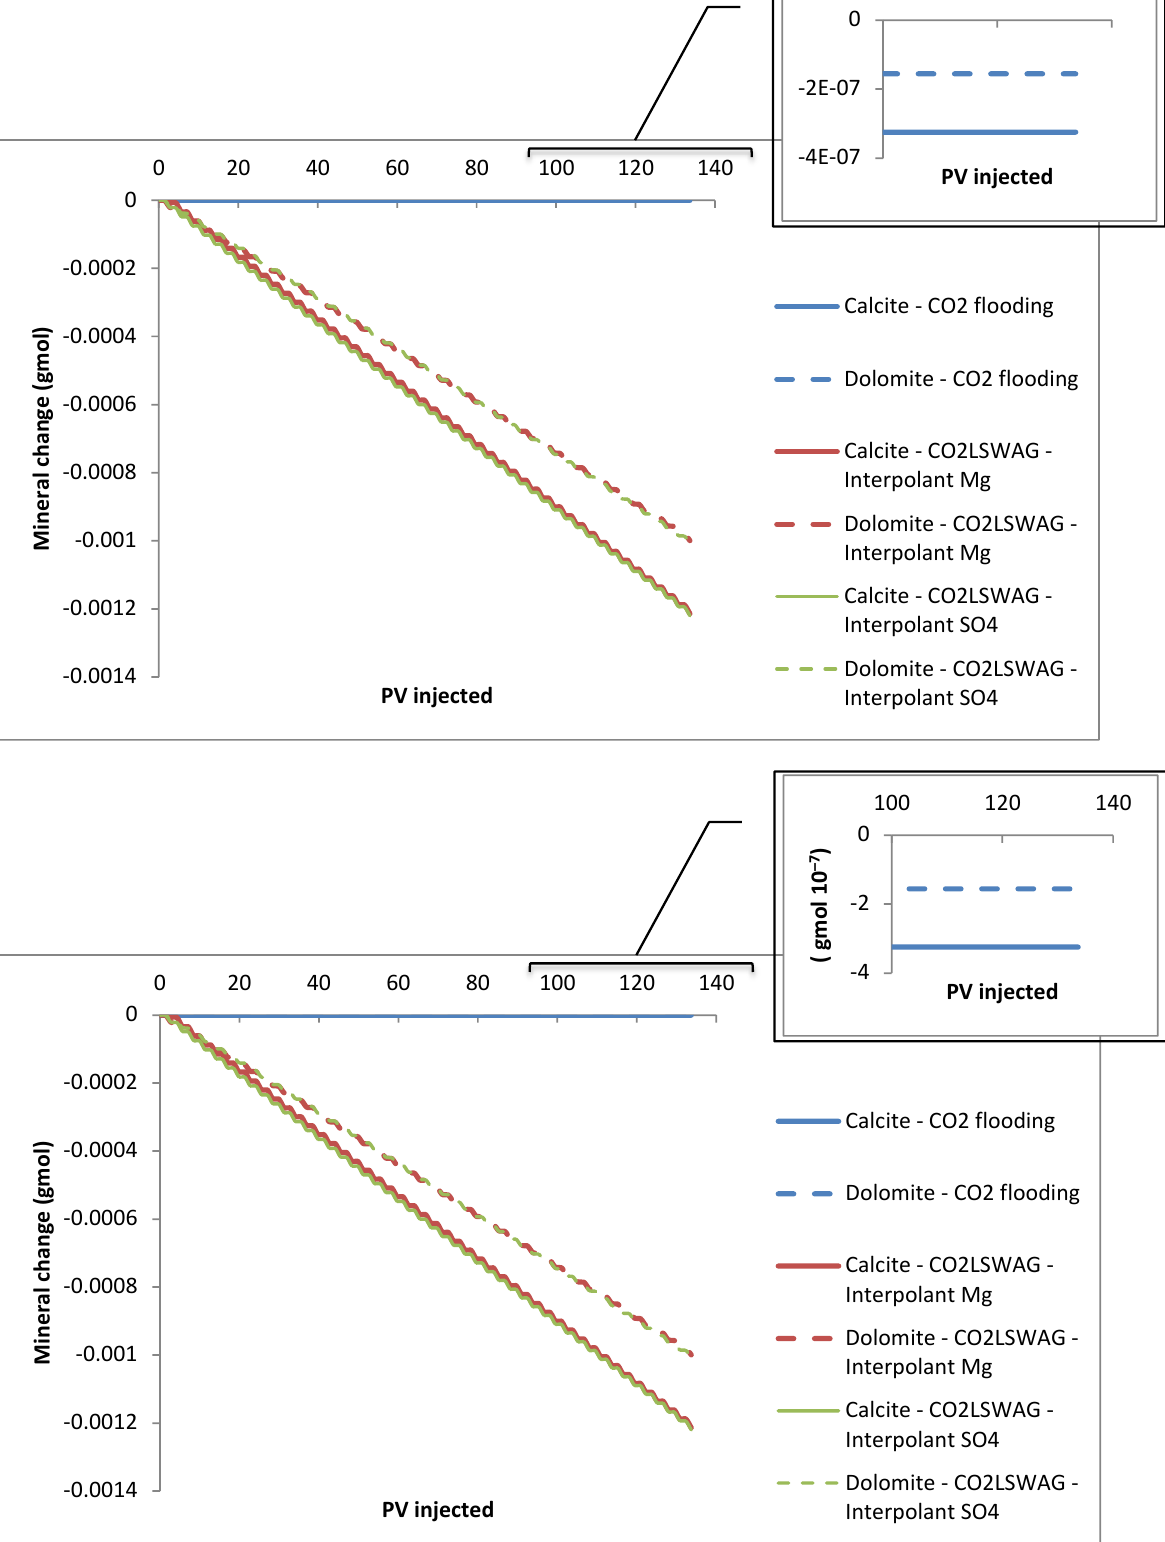
Figure 8. CO 2 molality in the aqueous phase for continuous CO 2 injection and CO 2 -LSWAG consid- ering Mg and SO 4 as ion interpolants — 10 porous volumes injected. Although the mineral composition variations are minimal, we can observe some im- portant points: